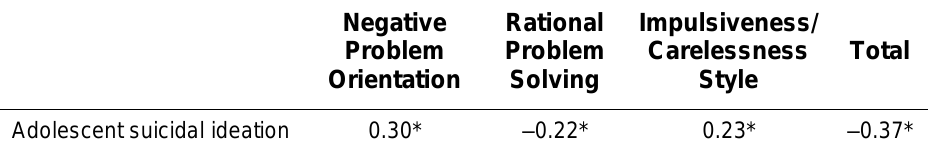
Correlations between Social Problem Solving and Adolescent Suicidal